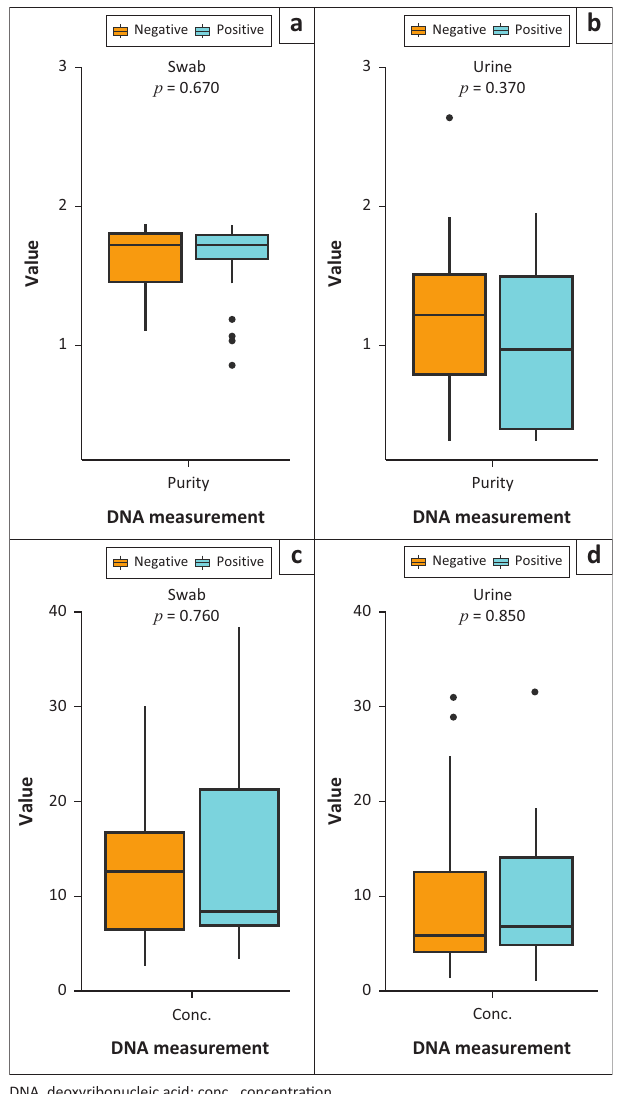
FIGURE 1: Comparison of the deoxyribonucleic acid purity and concentration values in the swab and urine samples across the bacterial vaginosis states. There was no significant difference ( p > 0.05) in deoxyribonucleic acid purity and concentration values in urine and swab samples across bacterial vaginosis- positive and bacterial vaginosis-negative samples. (a) DNA purity of swab samples, (b) DNA purity of urine samples, (c) DNA concentration of swab samples, (d) DNA concentration of urine samples.